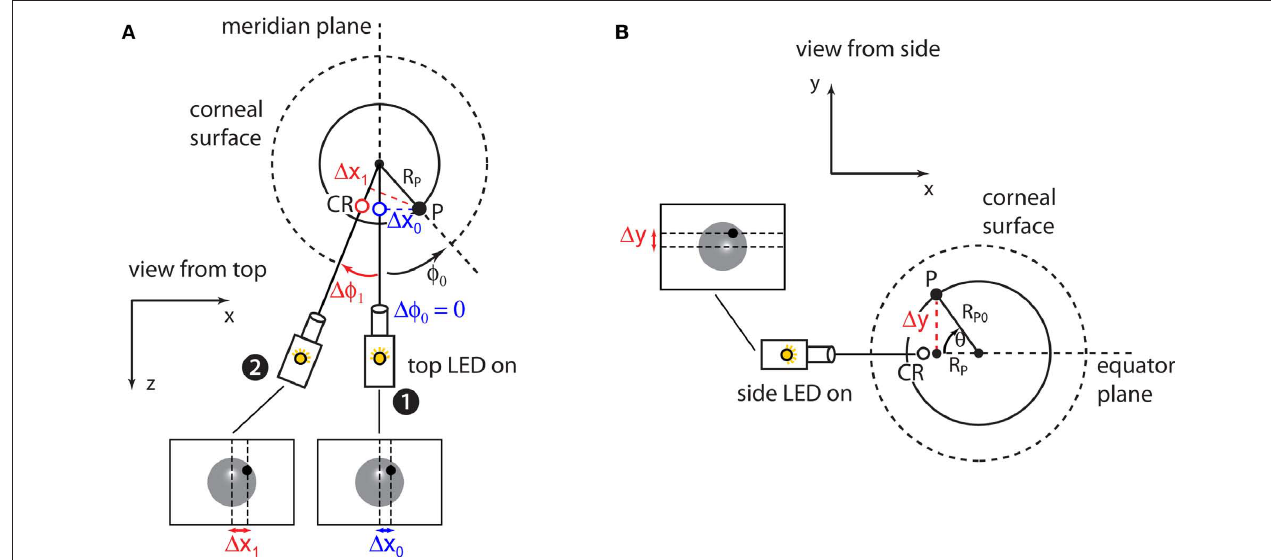
Figure 6 | estimation of the radius of pupil rotation. (A) At the end of the between the pupil eye’s equator plane; see also Figure 3 ) and an initial distance ∆ x 0 previous calibration steps (see Figures 4 and 5 ) the camera is in position 1, i.e., its and the eye’s meridian plane. When the camera is rotated to an angle ∆φ about the 1 sensor and the eye are aligned and the camera can be rotated about the center of center of the eye (red arrow), the distance ∆ x between the pupil and the eye’s 1 the eye (small black circle). Additionally, illumination from the horizontally aligned meridian plane will depend on both ∆φ and the pupil initial angle φ (see Eq. 3 in 1 0 (top) infrared LED results in a corneal reflection ( CR ; blue circle) that marks the Methods). (B) . Once RP is known by the fit to Eq. 3 (see Materials and Methods), meridian plane of the eye. Generally, the pupil ( P ; black circle) will not be aligned RP0 can be easily obtained by switching on the vertically aligned (side) infrared LED with the eye’s meridian plane (i.e., it will not point straight to the camera). This and measuring the distance ∆ y of the pupil from the eye’s equator plane (marked displacement can be described as an initial angle φ (black arrow) between the eye’s by the resulting CR spot; empty circle). In general, such a distance will not be null 0 meridian plane and R (the projection of the radius of rotation of the pupil R on the due to an initial elevation θ (black arrow) of the pupil from the equator P P 0